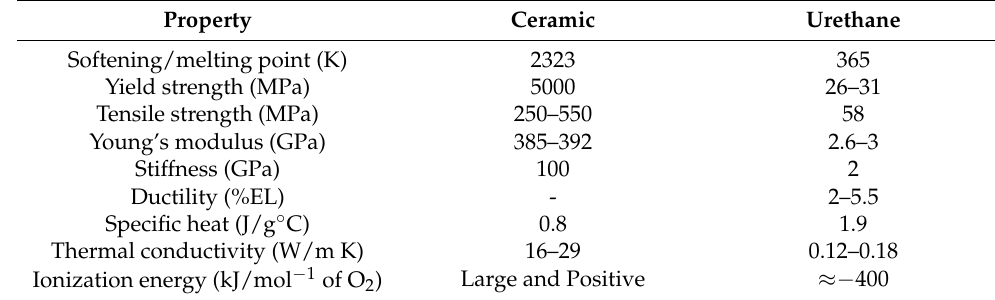
Table 1. Material